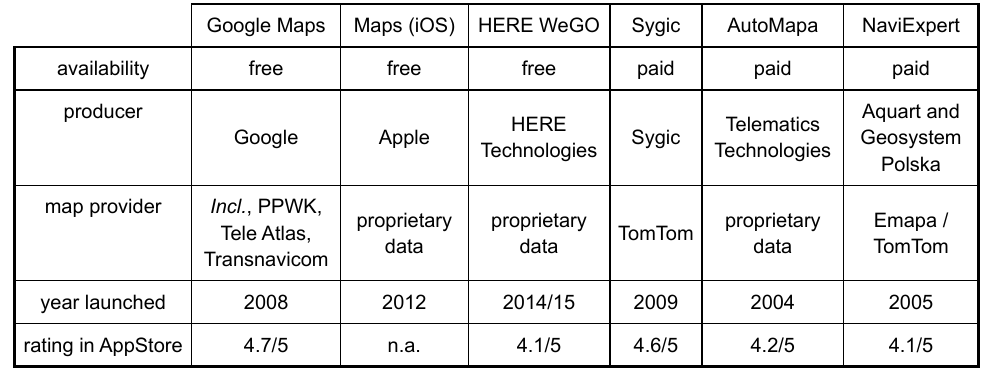
Table 1. The applications selected for testing Google